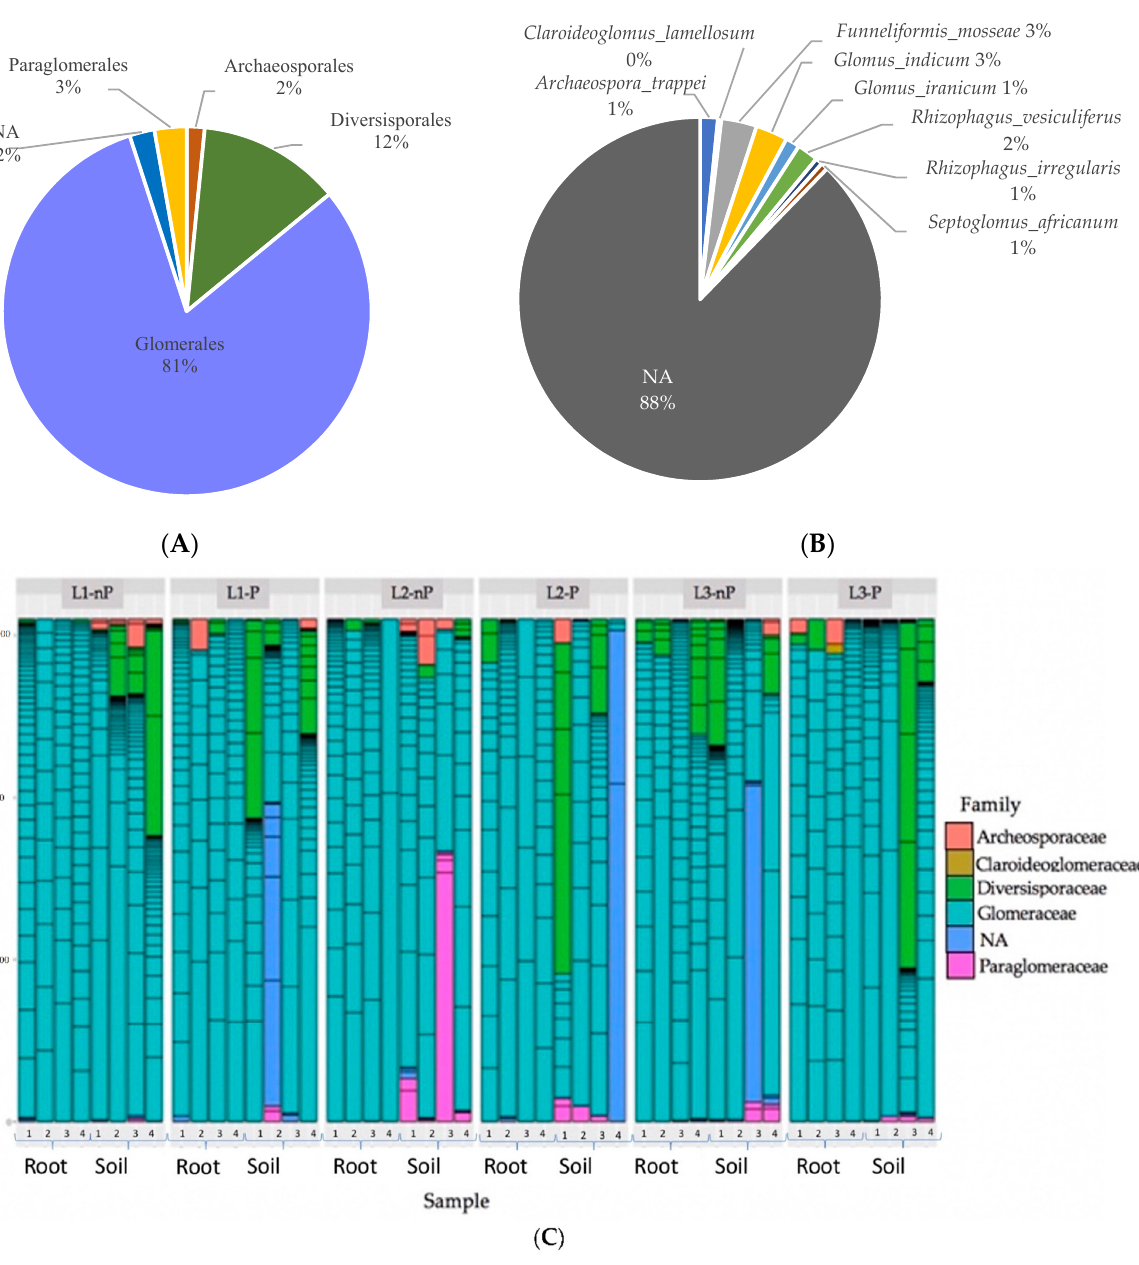
Figure 3. Taxonomic distribution of the 318 ASVs identified as Glomeromycota inside the entire mining area ( A ) at the order level, ( B ) at the species level, and ( C ) taxonomic distribution of the 318 ASVs at the family level inside each sample. “NA” category: ASV that did not obtain taxonomic assignment at the studied level.